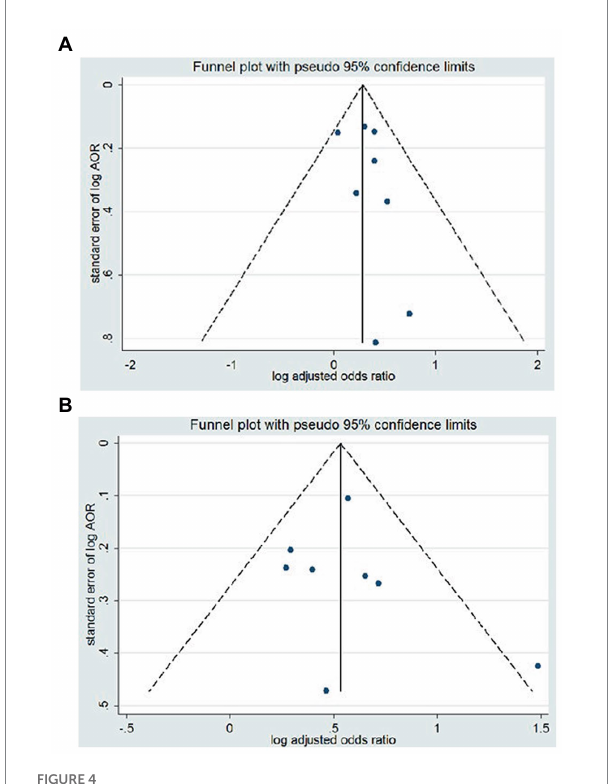
FIGURE 4 Funnel plots of the article included the association between migraine and (A) suicide ideation or (B) suicide attempts. AOR, adjusted odds ratio; CI, confidence